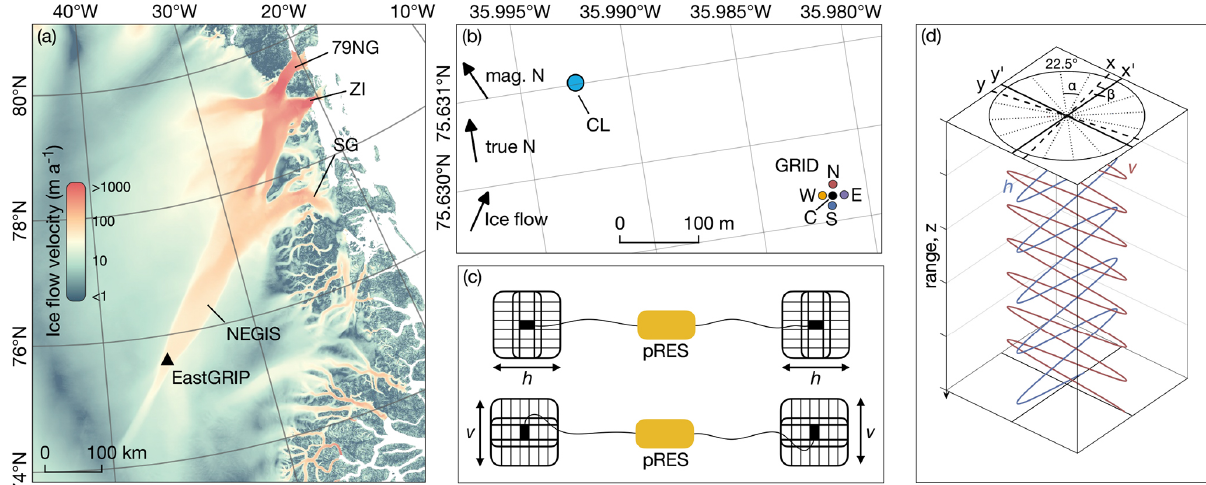
Figure 1. Location and orientation of polarimetric pRES measurements. (a) Surface ice flow velocity of the Greenland Ice Sheet (Joughin et al., 2016, 2018), showing the three major outlet glaciers of the Northeast Greenland Ice Stream (NEGIS): Nioghalvfjerdsbrae (79 N Glacier, 79NG), Zachariae Isstrøm (ZI) and Storstrømmen Glacier (SG). The location of the EastGRIP drill site is denoted by the black triangle. (b) Location of polarimetric pRES measurements at CL and at GRID. Arrows show the direction of the magnetic north, true north and ice flow. (c) Sketch of a polarimetric pRES measurement with hh and a vv antenna orientation. (d) Sketch of propagating waves with polarisations in the x (cid:48) ( h ) and y (cid:48) ( v ) directions (solid line) in the x – y coordinate system (dashed line). Dotted lines show the (unused) multi- polarised measurements, separated by α = 22 . 5 ◦ . Ice flow is in the x direction with an angular offset of β to the hh measurement in the x (cid:48)